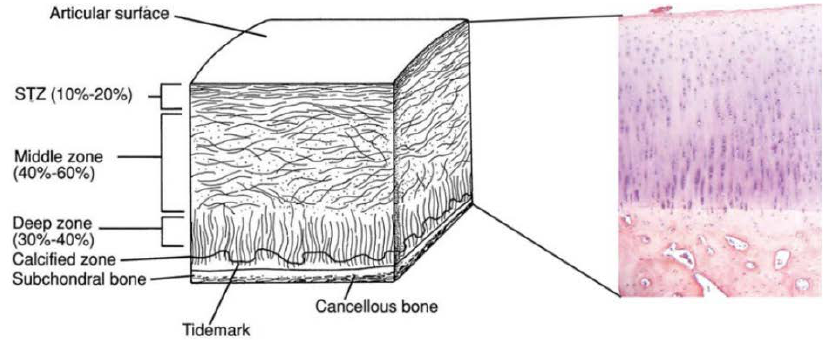
Figure 1. Schematic of osteochondral tissue and its components. Adapted with permission from ref [4]. Copyright 2015 by John Wiley & Sons, Inc.